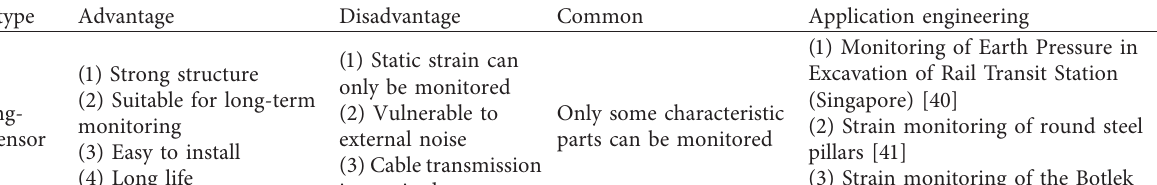
Figure 4: Principle of the optical fiber Table 2: Comparative analysis of the three types of sensors.